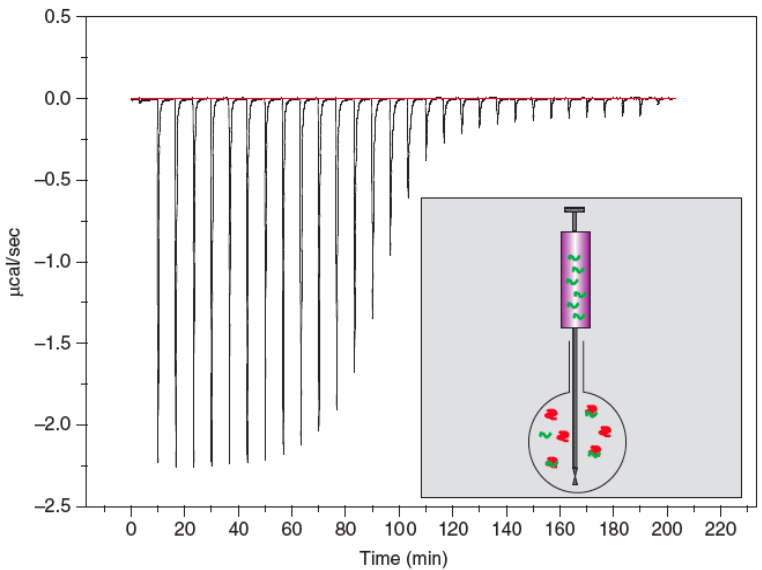
Figure 10. Isothermal titration calorimetry (ITC) setup (inlet) and typical measurement curve: the raw data and the isothermal. Reproduced from [86] with permission from